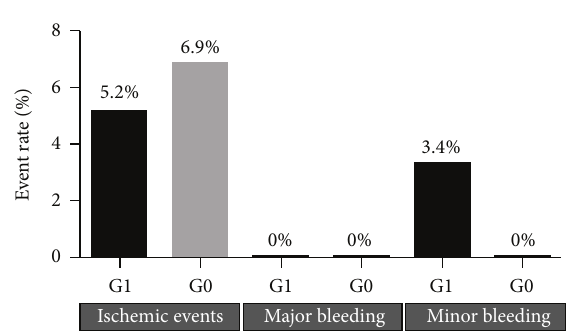
Figure 6: VWF levels in responders and nonresponders to tailored therapy ( T